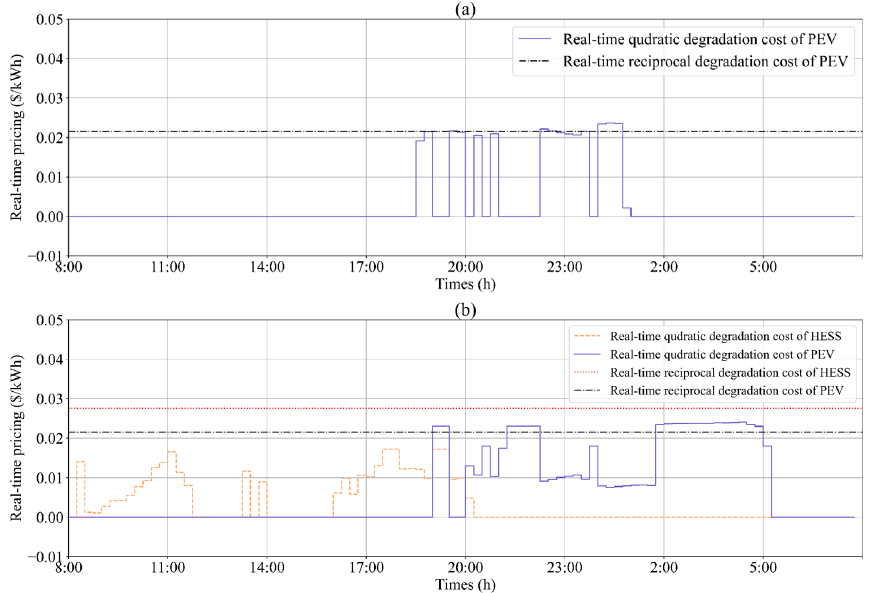
Figure 18. RTP comparison of degradation cost for ( a ) Case 1 vs. Case 5 and ( b ) Case 4 vs. Case 8.